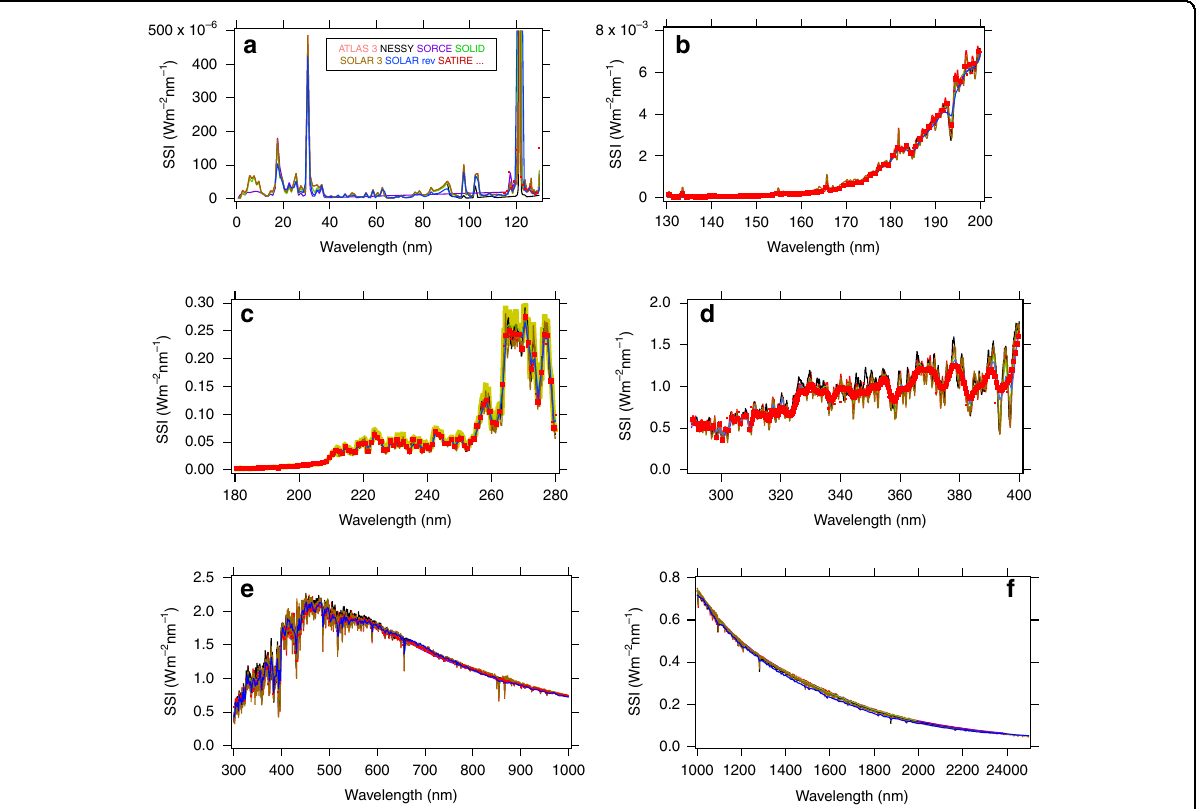
Fig. 6 Seven spectra around solar-activity minimum. a Seven spectra in the domain 0 – 130 nm. This wavelength range shows intense emission lines (e.g. He line at 30.5 nm), b seven spectra in the domain 130 – 200 nm. This wavelength range shows the transition from emission to Fraunhofer lines. c Seven spectra in the domain 180 – 280 nm. Above 200 nm, SSI shows many Fraunhofer lines, in which depths decrease as the wavelength increases (see d – f). d Seven spectra in the domain 280 – 400 nm. e Seven spectra in the domain 400 – 1000 nm. f Seven spectra in the domain 1000 – 2400